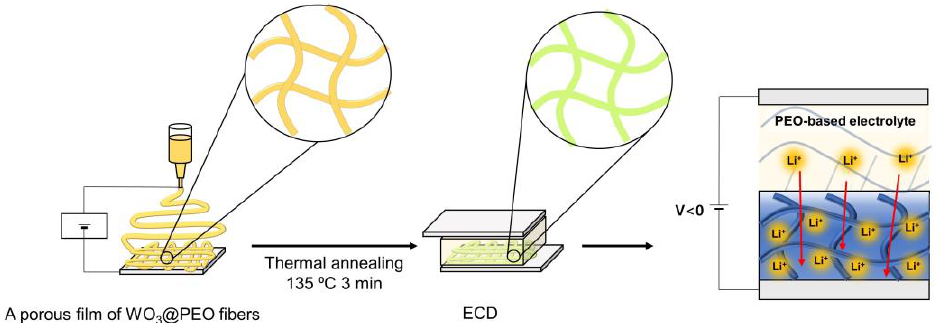
Figure 1. Schematic of the fabrication of the electrospun WO 3 @PEO-based electrochromic device.